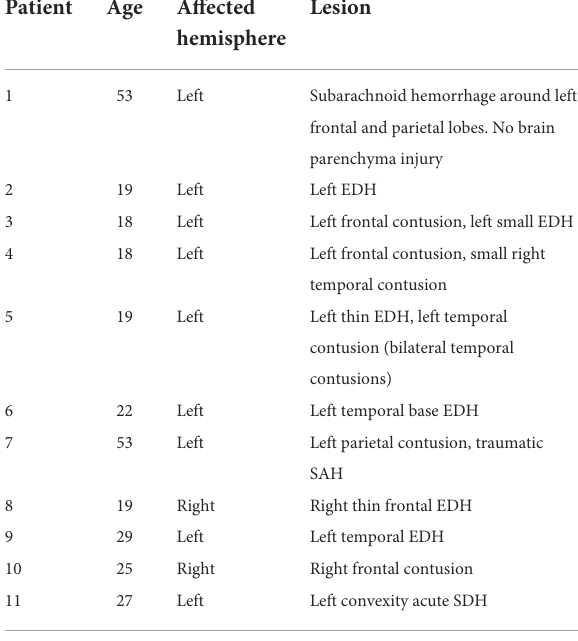
TABLE 2 Site and type of lesion in TBI patients during initial CT scan. TABLE 3 Neuropsychological performance for TBI and control groups.